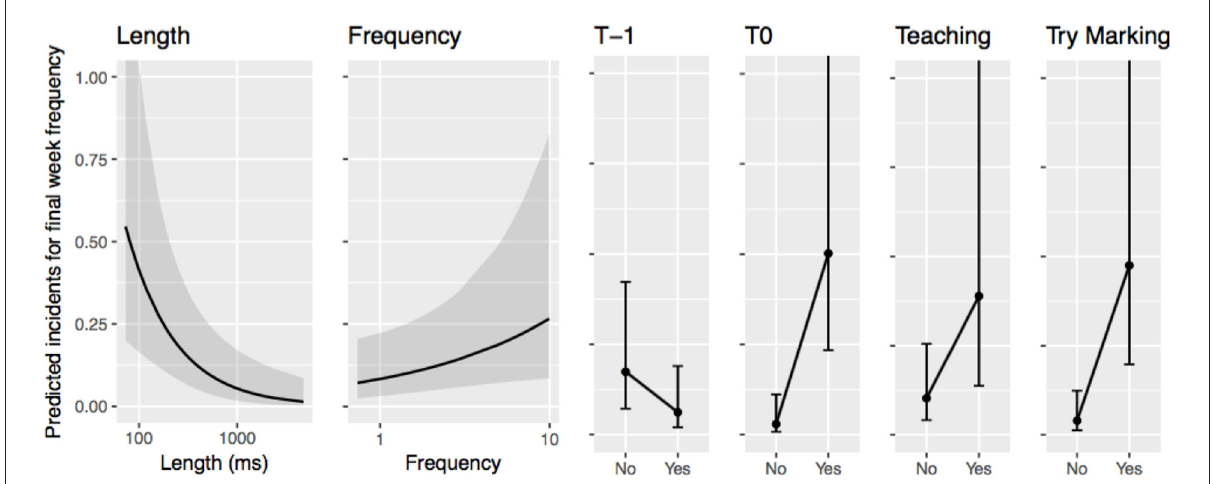
FIGURE6 Predicted incidents for final week frequency from the model for significant main effects. From left to right: length, frequency, T-1, T0, teaching, and try-marking. In the final four columns, the predictions are shown according to whether the variant did (“Yes”) or did not (“No”) appear in the particular context suggested by the heading. For example, variants used in try-marking situations had a higher final frequency than those that did not appear in try-marking situations. Points higher on the vertical axis in this figure indicate a higher likelihood of surviving to the final week. For length and frequency, the black line represents the model’s predictions: The probability of a variant surviving into the final week is higher for short, frequent variants. The gray ribbon represents the model’s uncertainty. For the last four plots, black dots represent the model’s predictions of the mean probability for each category of variant. The whiskers represent the uncertainty of the predictions. For four different interactional contexts, the prediction of the final week frequency is shown according to whether the variant is used (“Yes”) or not used (“No”) in that context.